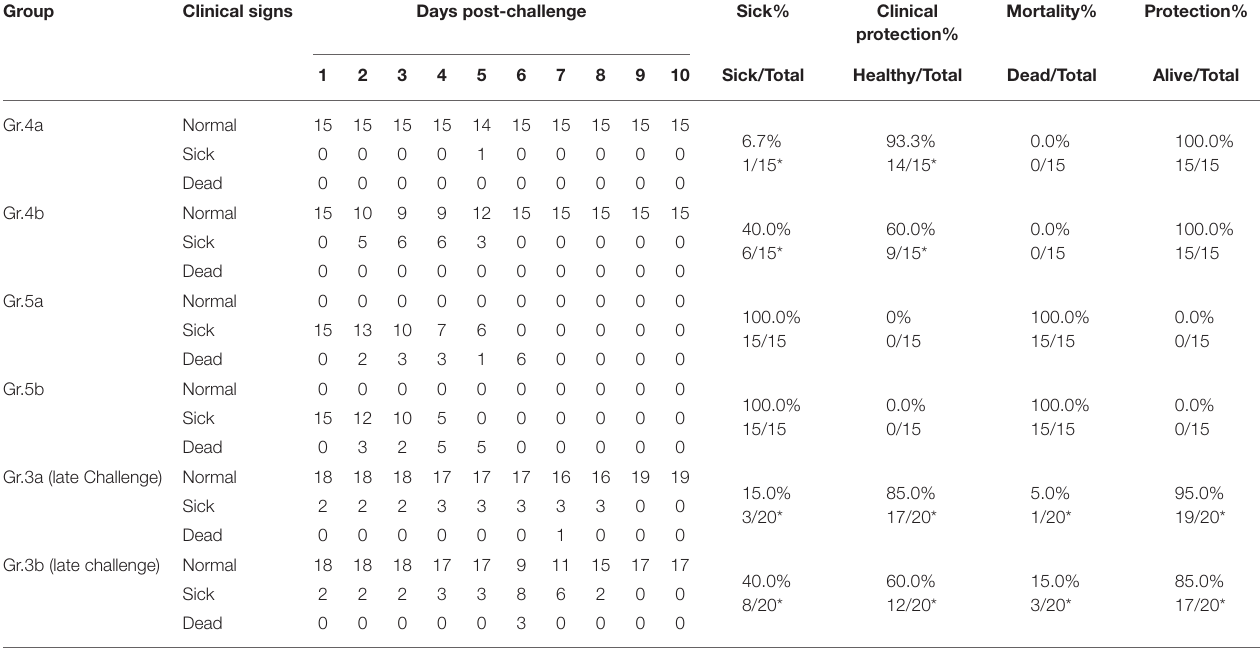
TABLE 4 | Experiment-2 (late challenge) protection